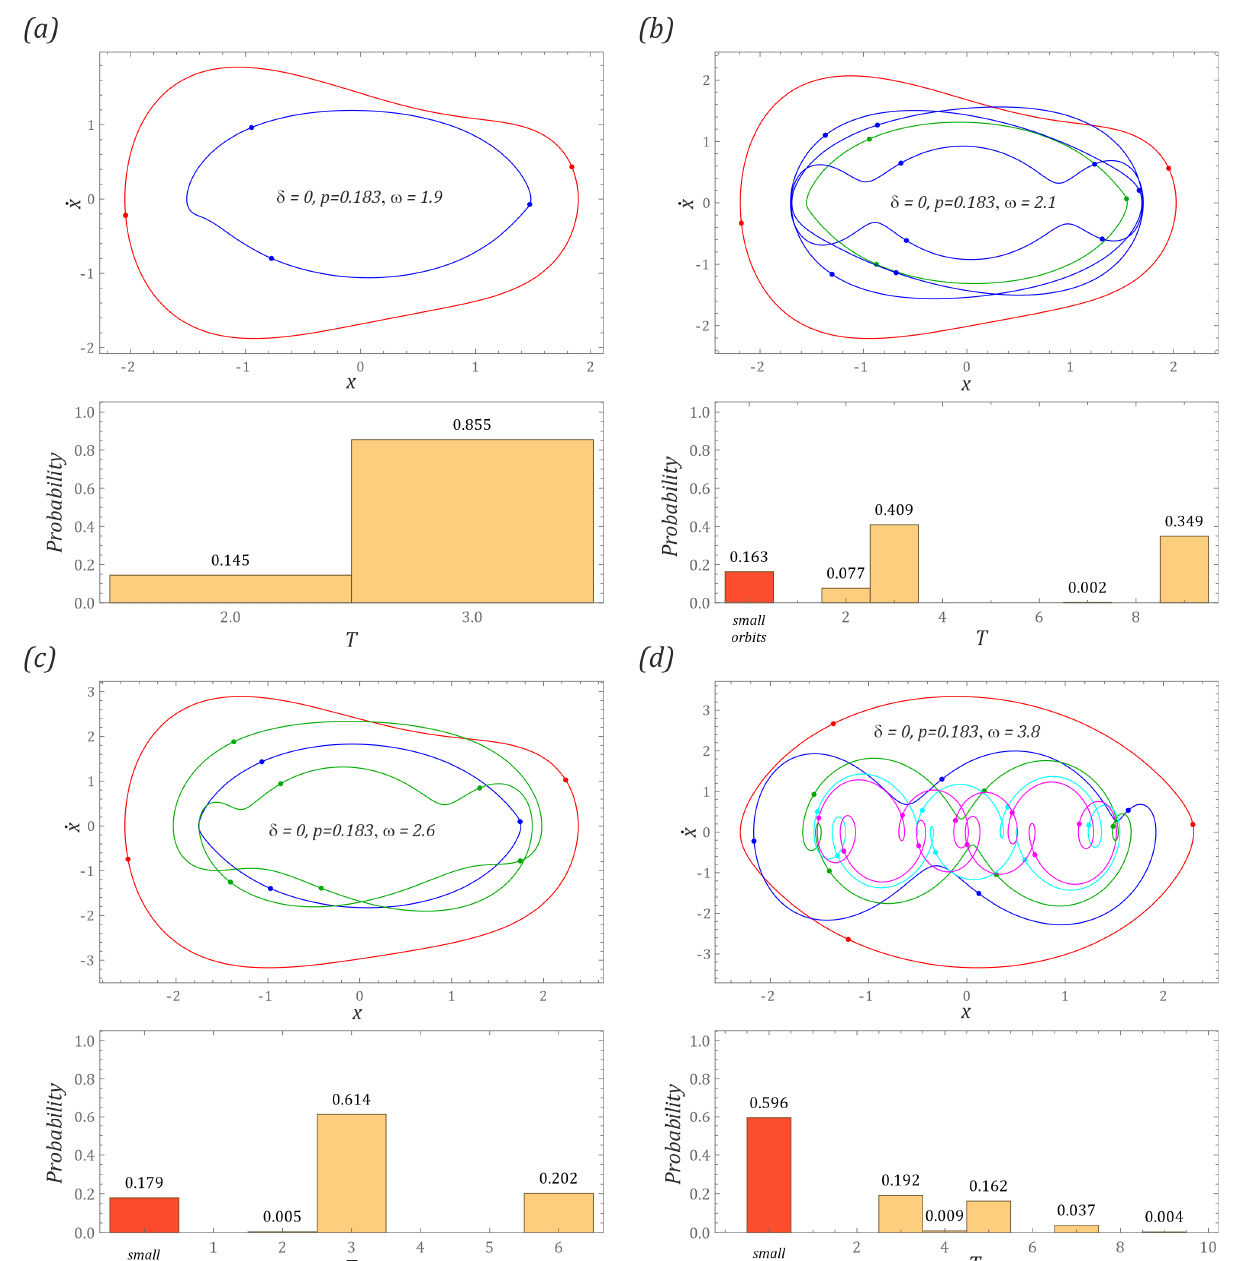
Figure 6. Examples of orbits of the coexisting periodic solutions together with the probability diagrams illustrating the probability of their achievement: ( a ) ω = 1.9, ( b ) ω = 2.1, ( c ) ω = 2.6, ( d ) ω = 3.8. Note that the Poincaré points denoted by the black circles correspond to the numbers of excitation input periods for a single output period of system response. The horizontal axis T is related to the excitation period, and it is the unit of the response periodicity in the response probability diagrams.